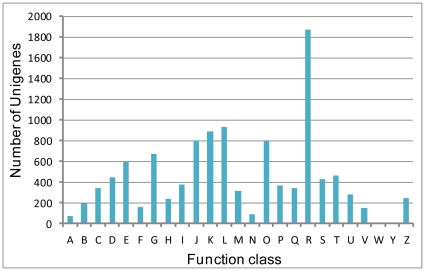
COG classification of the unigenes.A: RNA processing and modification; B: Chromatin structure and dynamics; C: Energy production and conversion; D: Cell cycle control, cell division, chromosome partitioning; E: Amino acid transport and metabolism; F: Nucleotide transport and metabolism; G: Carbohydrate transport and metabolism; H: Coenzyme transport and metabolism; I: Lipid transport and metabolism; J: Translation, ribosomal structure and biogenesis; K: Transcription; L: Replication, recombination and repair; M: Cell wall/membrane/envelope biogenesis; N: Cell motility; O: Posttranslational modification, protein turnover, chaperones; P: Inorganic ion transport and metabolism; Q: Secondary metabolites biosynthesis, transport and catabolism; R: General function prediction only; S: Function unknown; T: Signal transduction mechanisms; U: Intracellular trafficking, secretion, and vesicular transport; V: Defense mechanisms; W: Extracellular structures; Y: Nuclear structure; Z: Cytoskeleton.